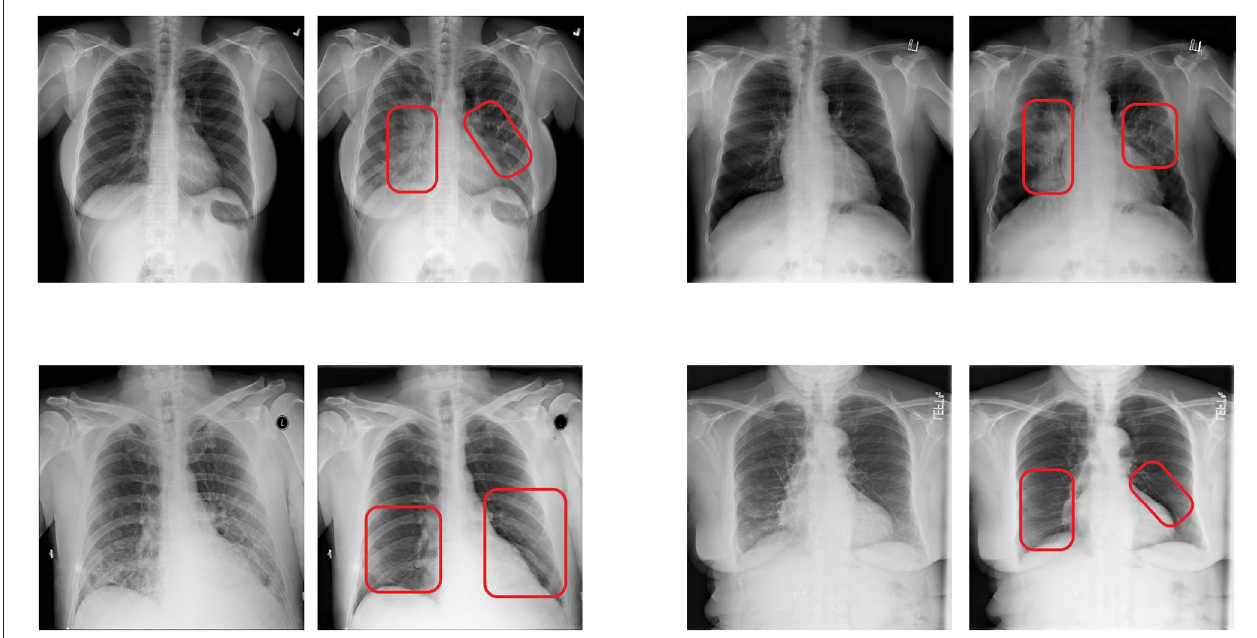
FIGURE 3 | Examples of counterfactual images produced with our proposed approach. In each pair, the left image shows the original image, while the right image shows the corresponding counterfactual explanation. The red boxes were added manually to point the reader to the regions that were altered the most. The original images in the top row were classified as normal , while the original images in the bottom row were classified as pneumonia . The shown counterfactual images were all classified as the opposite as their respective